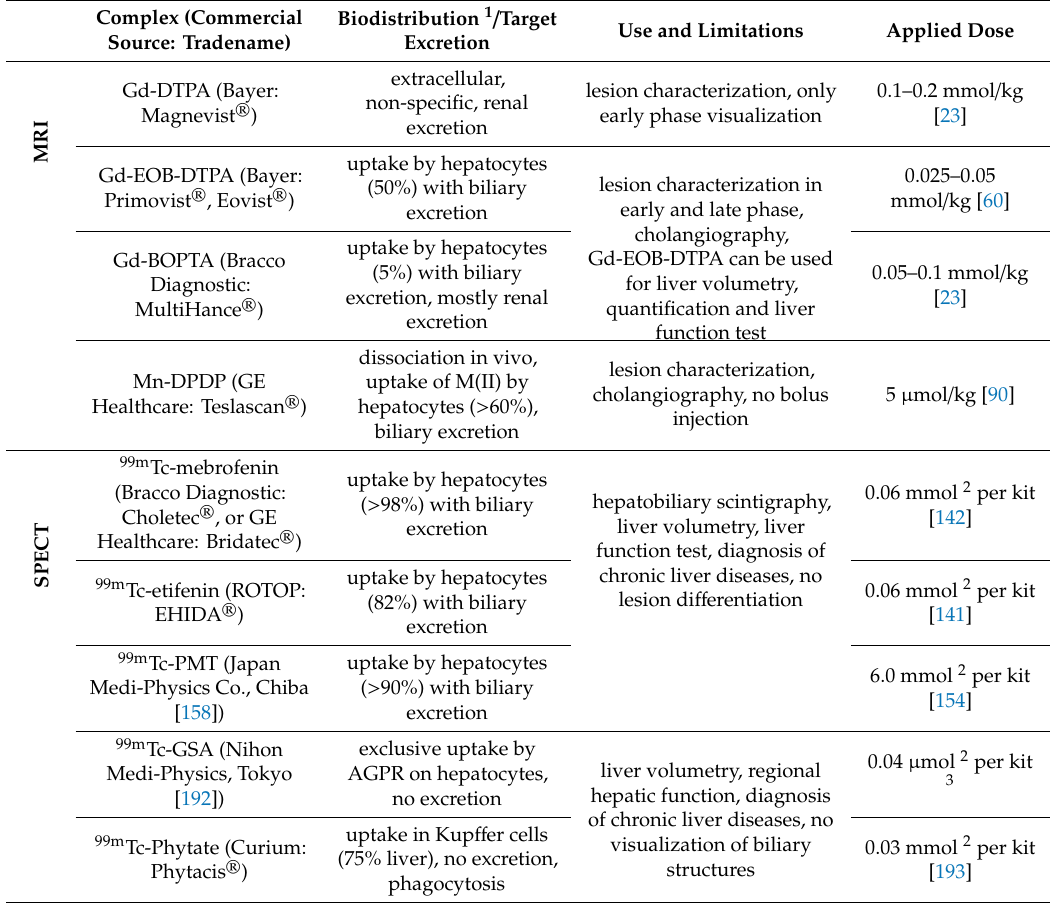
Table 1. List of commercially available metal complexes applicable in MRI and SPECT liver